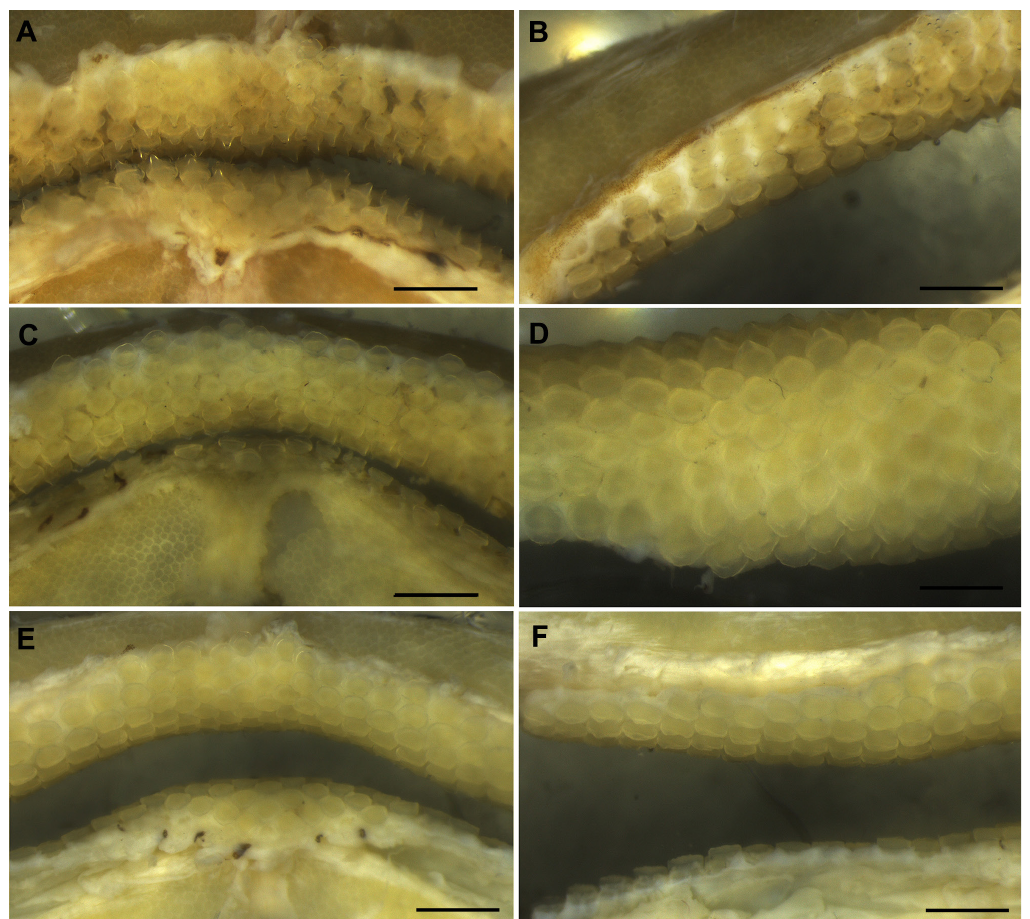
FIGURE 18 | Teeth of Atlantoraja species. A. Symphyseal region, B. Commissural region of A. castelnaui , UERJ 1853, male, 593 mm TL. C. Symphyseal region, D. Commissural region of A. cyclophora , MNRJ 117184, female, 583 mm TL. E. Symphyseal region, F. Commissural region of A. platana , UERJ 1383, male, 372 mm TL. Scale bars = 5